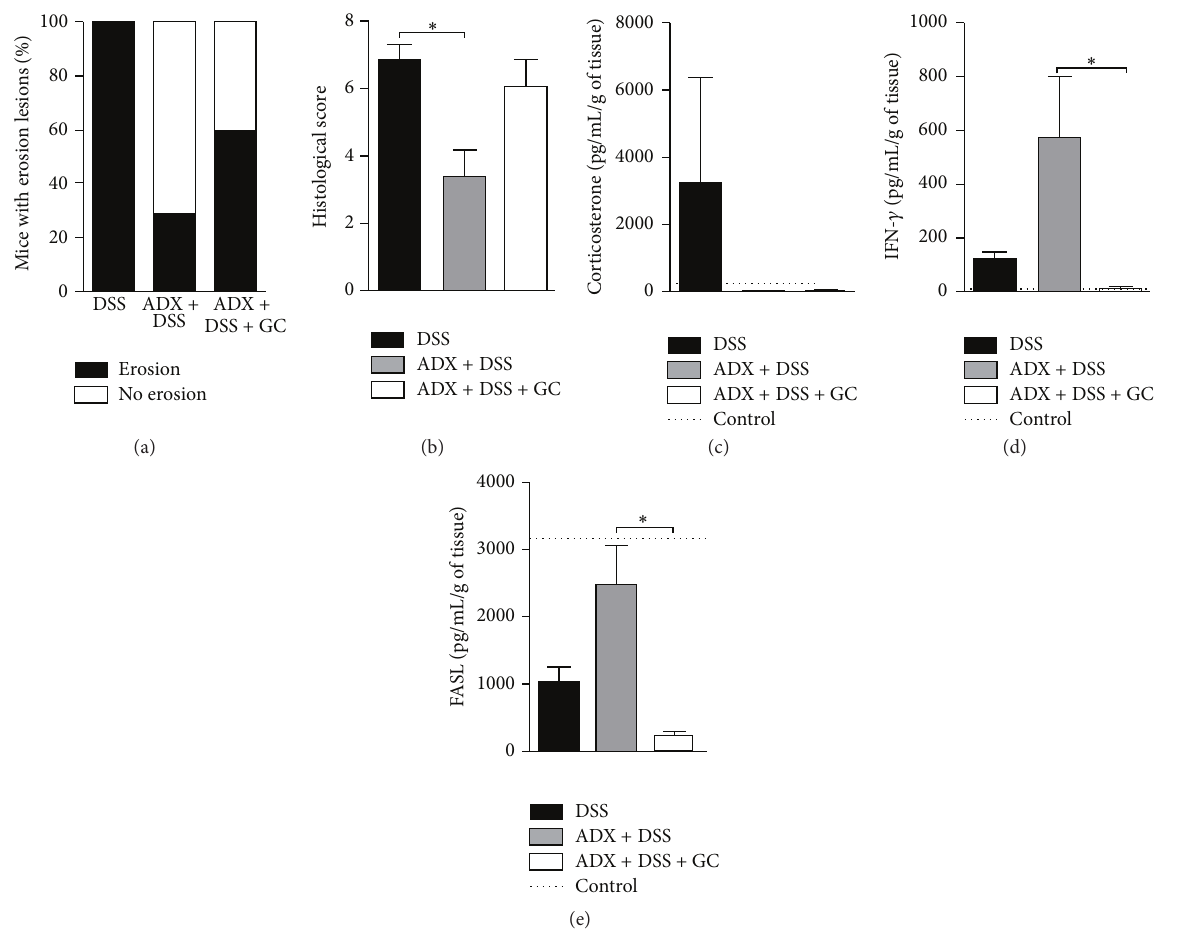
Figure 5: Adrenal-derived glucocorticoid is one of the key players in the control of intestinal inflammation. C57BL/6 mice were adrenalectomized and exposed to dextran sulfate sodium (DSS) 3%. After surgery, a group of mice was treated i.p. with 1mg/Kg/day of dexamethasone from the 3rd to the 5th day of colitis, for replacement of GC, as described in Material and Methods. The colon was collected on the 6th day of colitis for histological analysis (a and b): (a) erosion lesions; (b) histological score; (c) intestinal corticosterone levels; (d) IFN- 𝛾 ; and (e) FasL levels. DSS: C57BL/6 mice exposed to DSS; ADX + DSS: C57BL/6 adrenalectomized mice exposed to DSS. ADX + DSS + GC: C57BL/6 adrenalectomized mice exposed to DSS and treated with dexamethasone. The dotted lines correspond to the control group of C57BL/6 mice without colitis. Results are representative of two independent experiments, with 5 mice/group. ∗ 𝑝 < 0.05